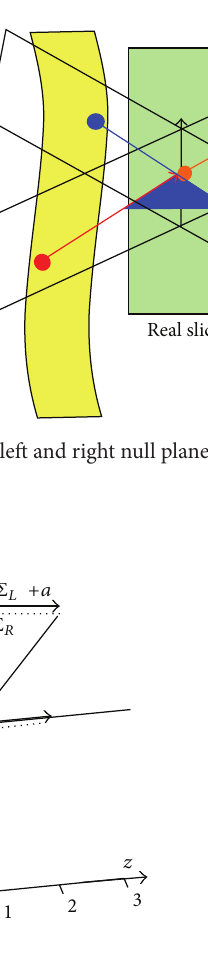
Figure3:Endsoftheopencomplexstring,associatedwithquantum numbers of quark-antiquark pair, are mapped onto the real half- infinite 𝑧 + , 𝑧 − axial strings. Dotted lines indicate orientifold projec-